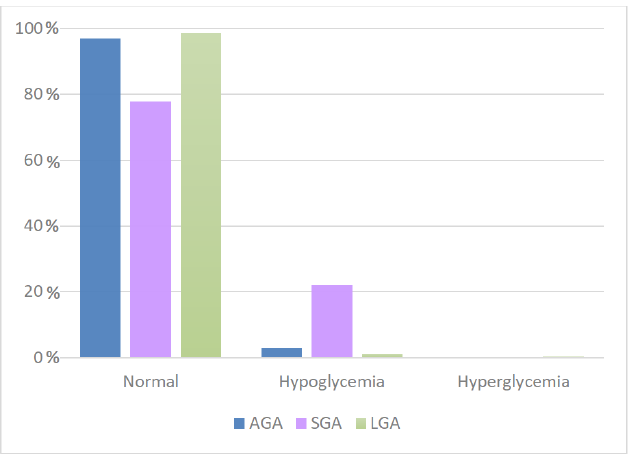
Table 6. Association between weight for GAs and blood glucose alterations in patient in continuous feeding. p -value = 0.001. AGA, appropriate for gestational age; SGA, small for gestational age; LGA, large for gestational age.